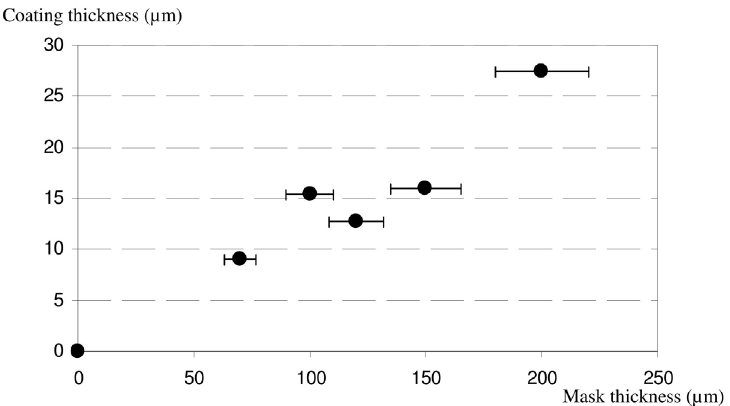
Figure 2. Coating thickness vs. mask